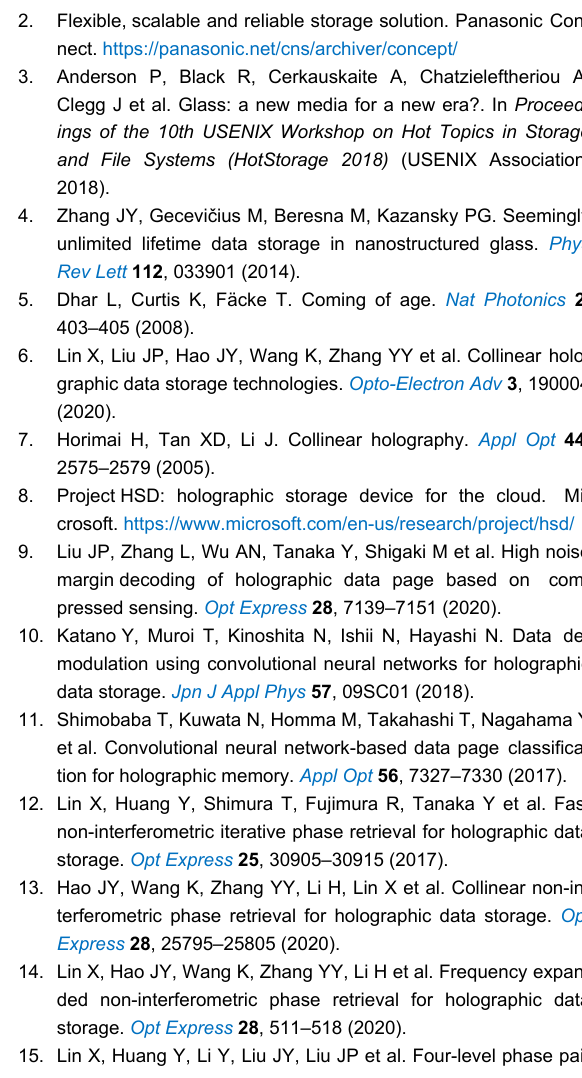
Fig. 15 | Superposition distribution of errors of all retrieved images in the data set. ( a ) Pixel differences of the amplitude training set. ( b ) Er- ror data of the decoded amplitude pages in the training set. ( c ) Pixel differences of the phase training set. ( d ) Error data of decoded phase pages in the training set. ( e ) Pixel differences of the amplitude test set. ( f ) Error data of the decoded amplitude pages in the test set. ( g ) Pixel differ- ences of the phase test set. ( h ) Error data of the decoded phase pages in the test set. ( k ) Intensity image under the influence of